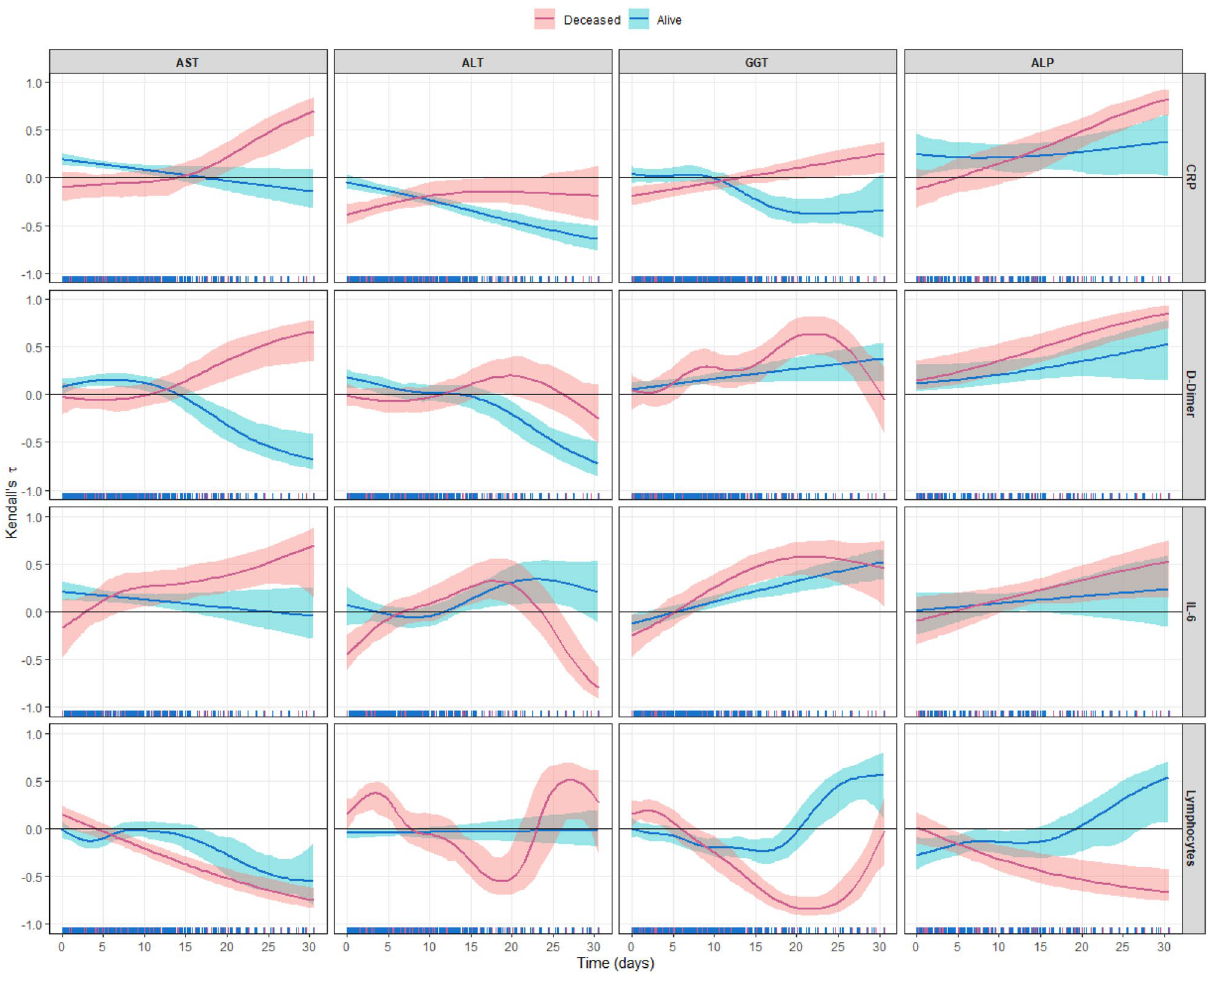
Figure 3. Time variation of the correlation between the weighted and Box–Cox-transformed transaminases and the weighted and/or Box–Cox-transformed (if required) inflammation markers for deceased (pink) and living (blue) patients, expressed by means of Kendall’s τ coefficient (with 95% CI). The horizontal line indicates zero correlation, and when it lies inside the 95% CI, no correlation was